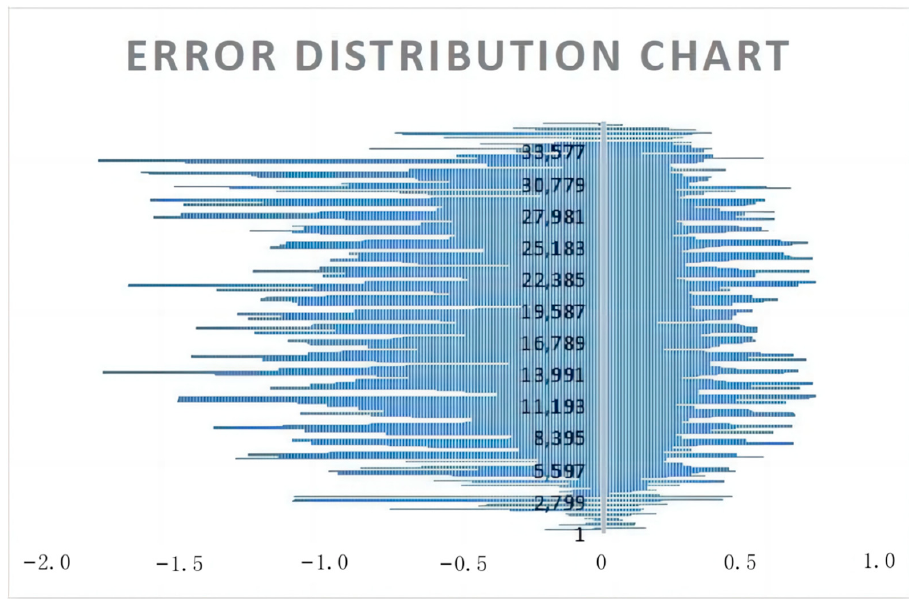
Figure 14. Error analysis